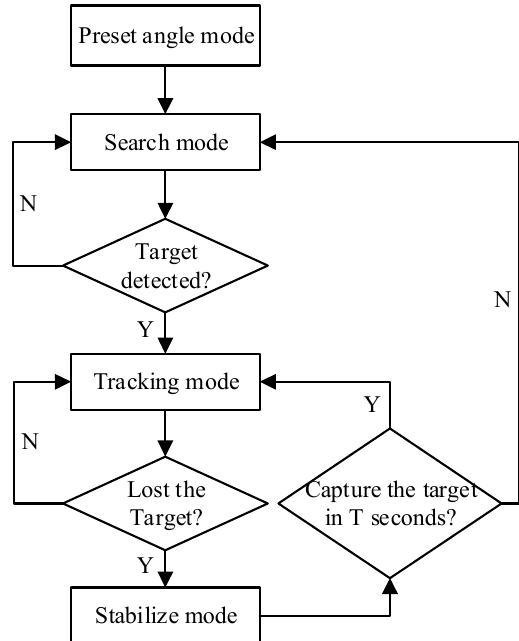
Figure 7. Diagram of the system operation modes.